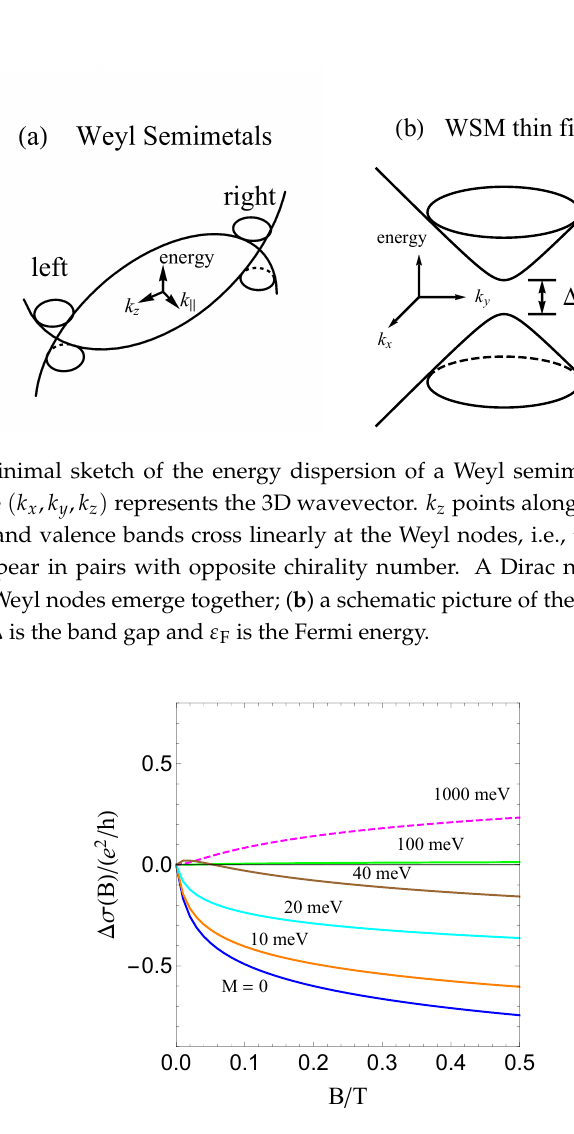
Figure 6. The magnetoconductivity ∆ σ ( B ) plots at λ = 0.5 for different masses M . The parameters used are A = 300 meV · nm, n e = 0.01 nm − 2 , n i = 0.0001 nm − 2 and (cid:96) φ = 500 nm, according to